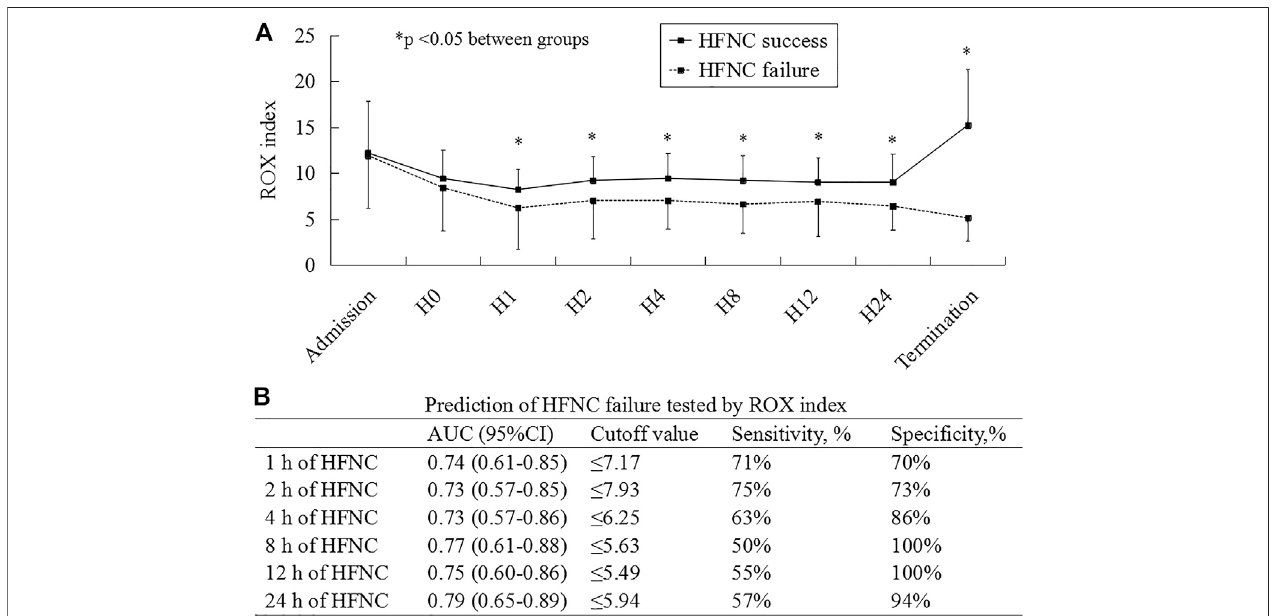
FIGURE 2 | ROX index as a risk factor to predict HFNC failure. H0, H1, H2, H4, H8, H12, and H24 mean the data collected before and at 1, 2, 4, 8, 12, and 24 h HFNC, respectively. ROX, the ratioof SpO 2 /F i O 2 to the respiratory rate; HFNC, high- fl ownasalcannula; AUC, area under the curve ofreceiver operating characteristics; CI, con fi dence interval.